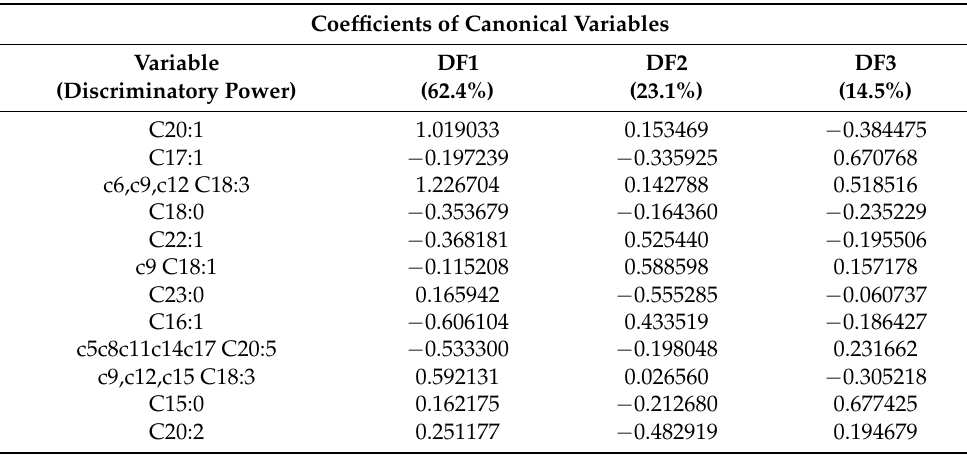
Table A9. Coefficients and average value of canonical variables included in the final model